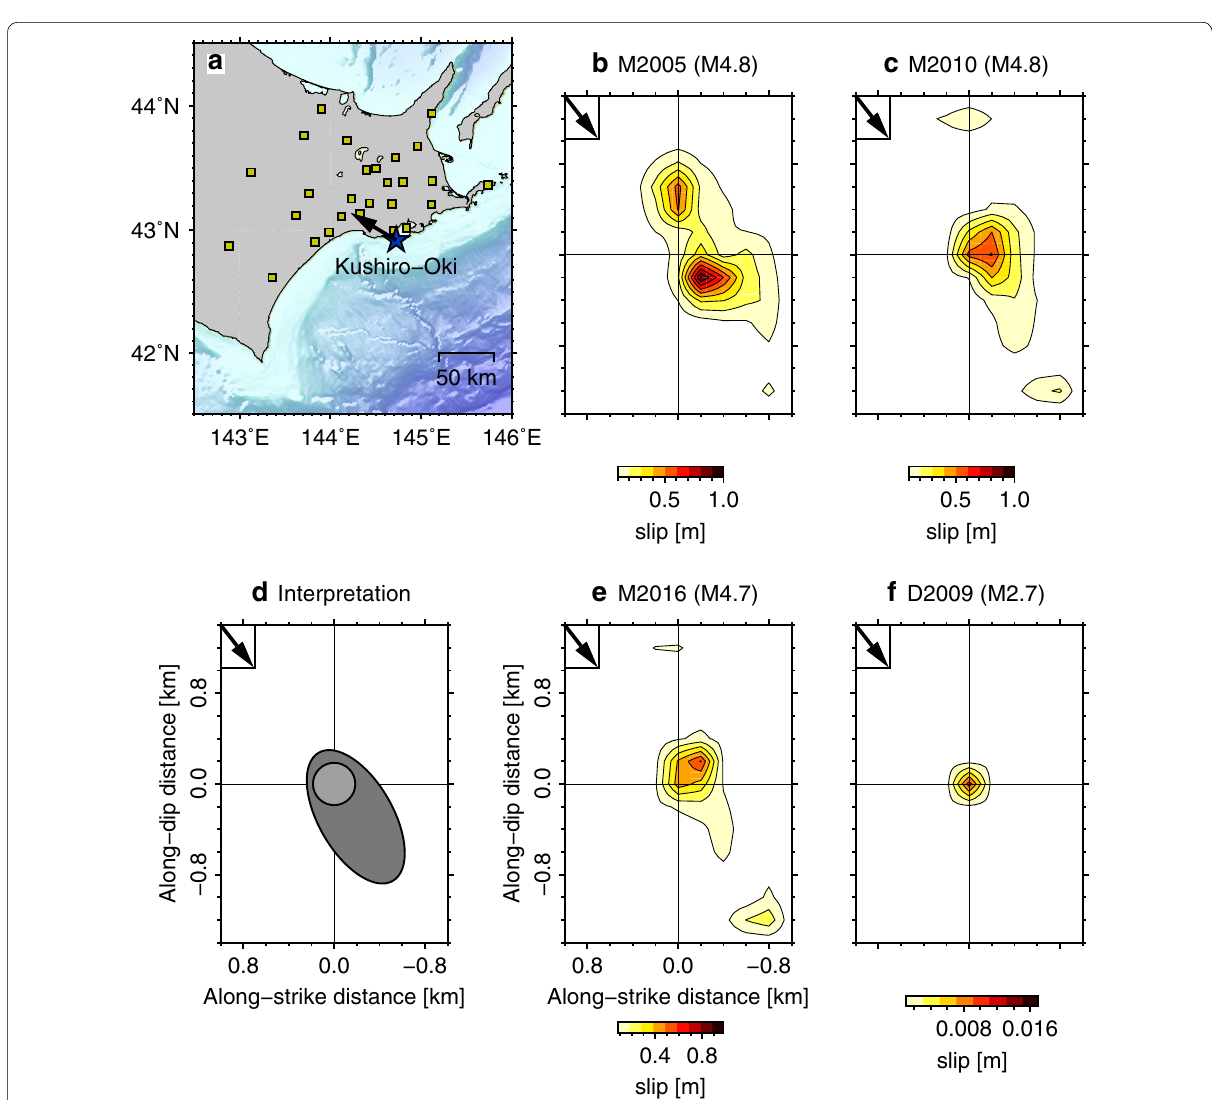
Fig. 6 Total slip distributions of the Kushiro-Oki earthquakes. a Map showing the locations of the stations (yellow squares) used in the waveform inversion, relative to the Kushiro-Oki events (blue star), with the slip direction indicated by the black arrow. Total slip distributions of M2005 b , M2010 c , M2016 e , and D2009 f , projected onto common spatial coordinates. d Interpretation of the characteristic structure represented by two patches elongate in the slip direction on the plate interface in the Kushiro-Oki